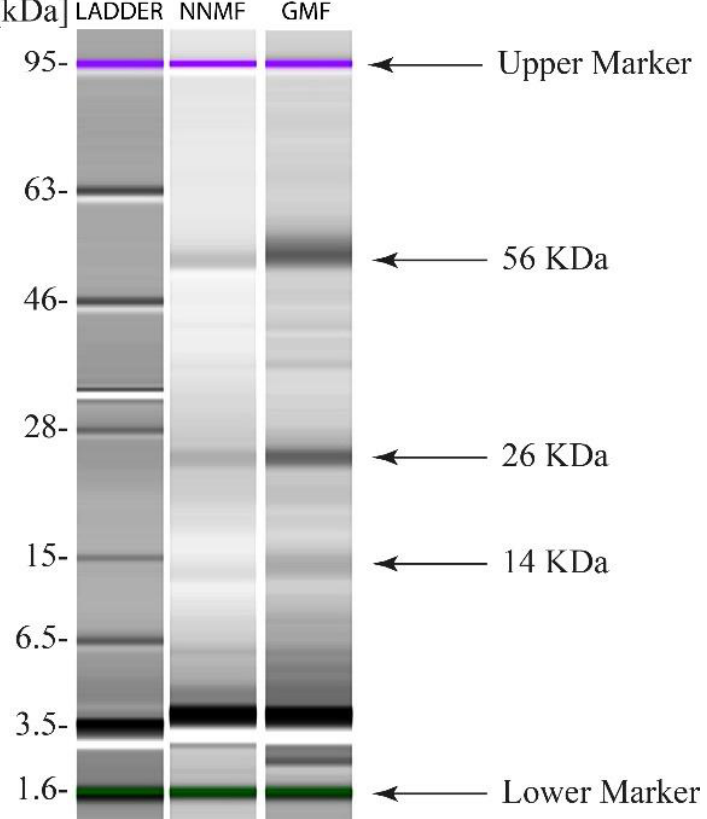
Figure 6. SDS Capillary gel electrophoresis (Agilent 2100 Bioanalyzer) of leaf proteins from Lima bean plants exposed to GMF and NNMF.